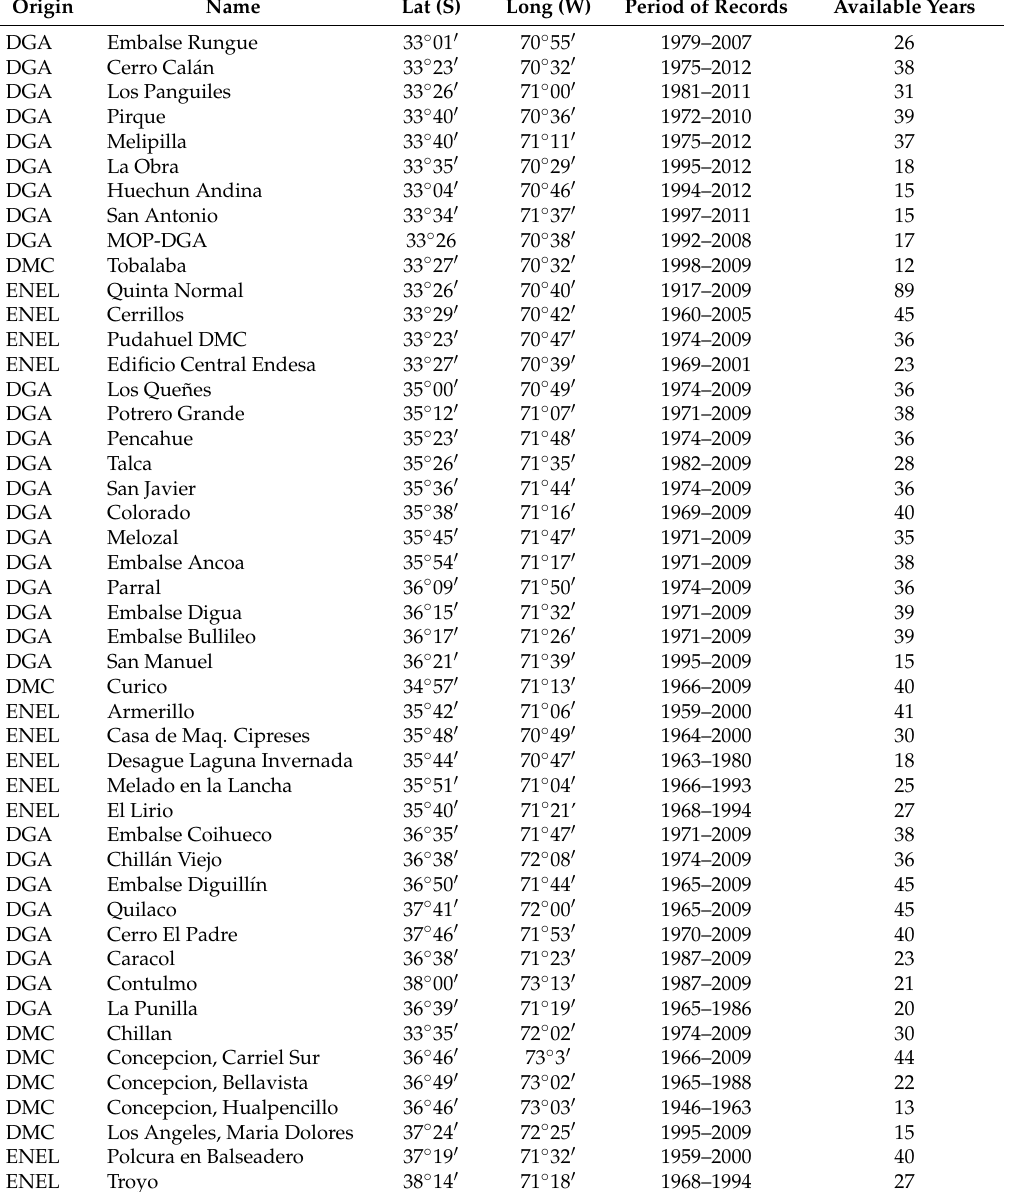
Table A1. Pluviograph gauges included in WEBSE IDF . The pluviographs bands were contributed by three Intitutions: The National Directorate of Water Resources (DGA), The National Company of Electricity (ENEL), and the National Meteorological Directorate